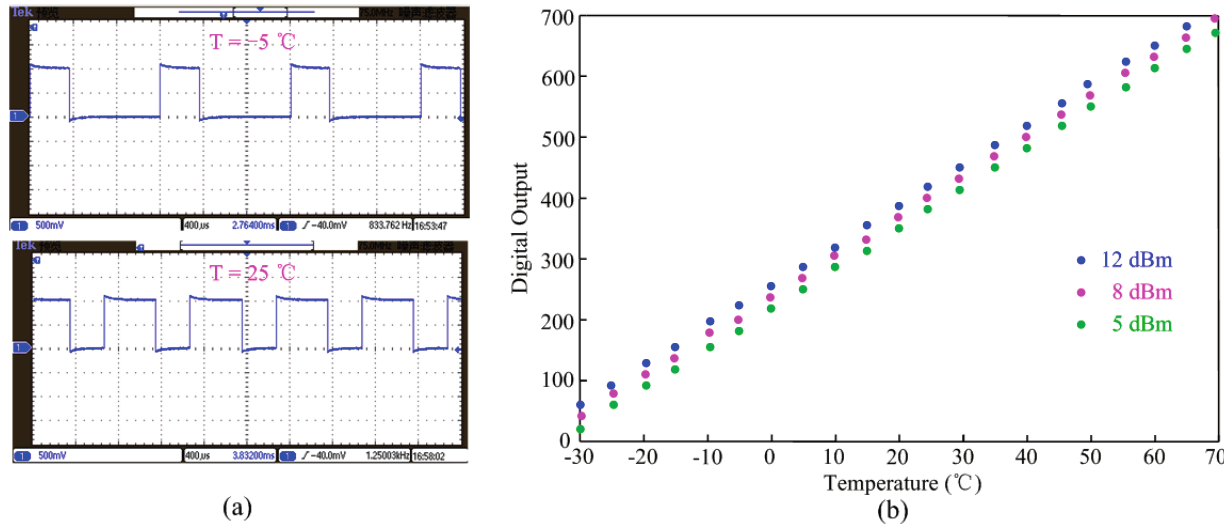
Figure 8. Performances of the test temperature sensor; ( a ) corresponding outputs of the sensor interface at − 5 °C and 25 °C; ( b ) digital output of baseband vs.